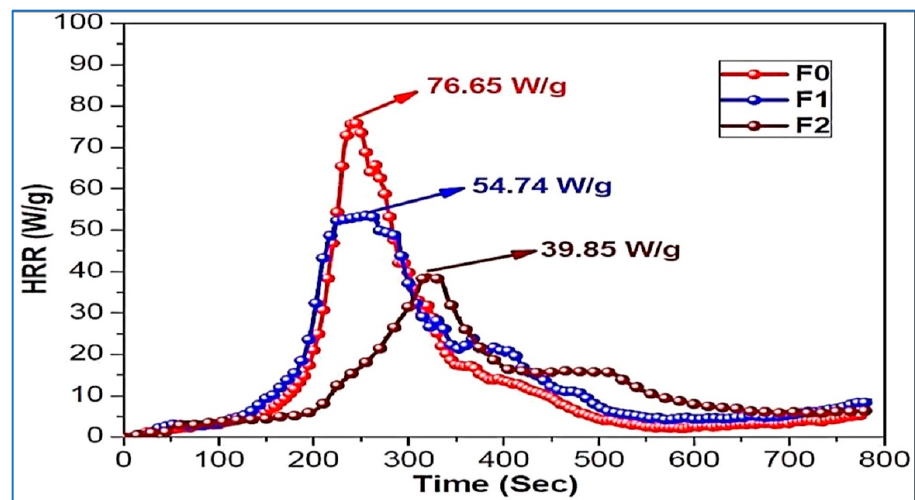
Figure 6. Heat release Rate (HRR) vs. time curves for the different systems investigated: F0 (without silica nanoparticles), F1 (with 2% w / w silica nanoparticles) and F2 (with 4% w / w silica nanoparticles). Reprinted with permission from [37]. Copyright 2020, Elsevier.